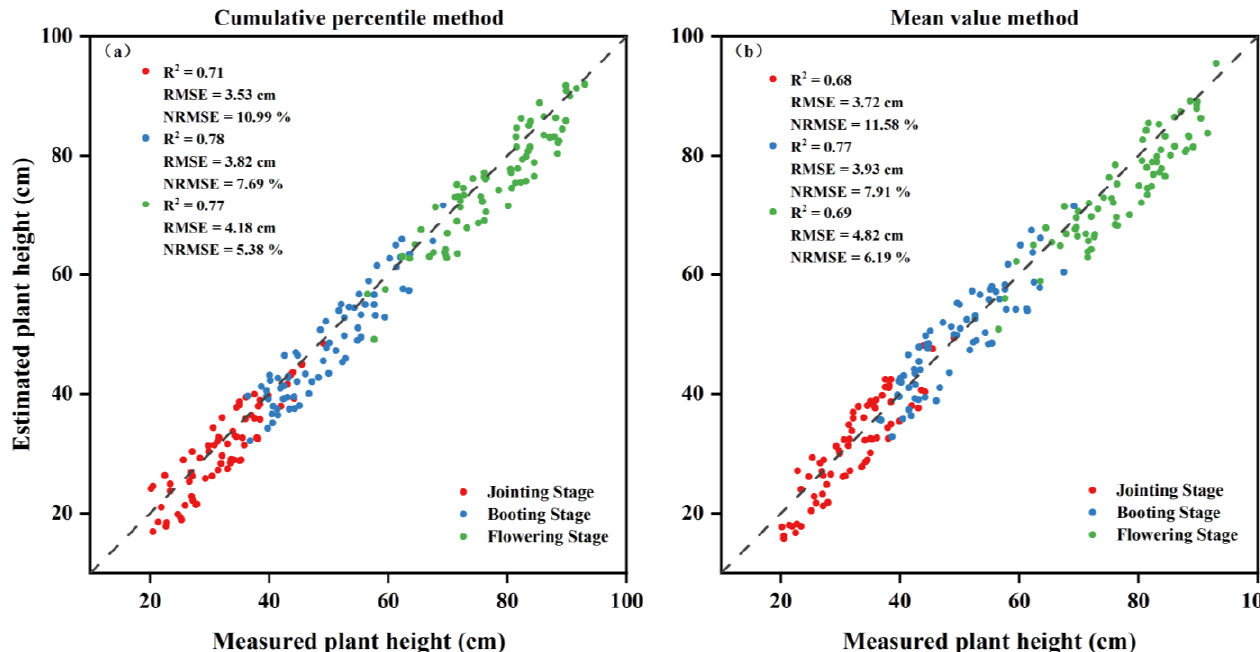
Figure 4. Relationship between measured and estimated plant height (cm) using the ( a ) cumulative percentile method and the ( b ) mean value method.